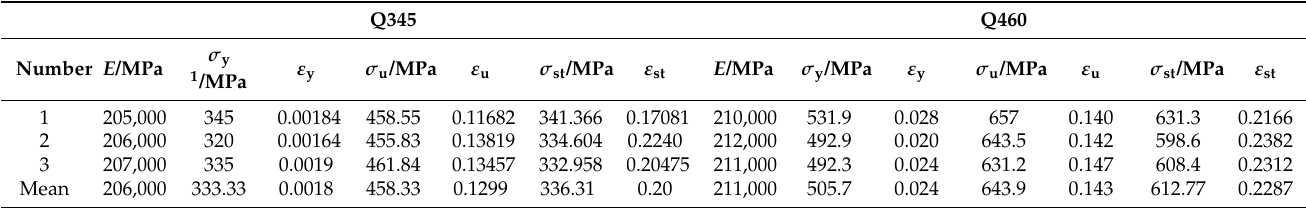
Table 1. Material properties of Q345 steel used in ABQUAS.